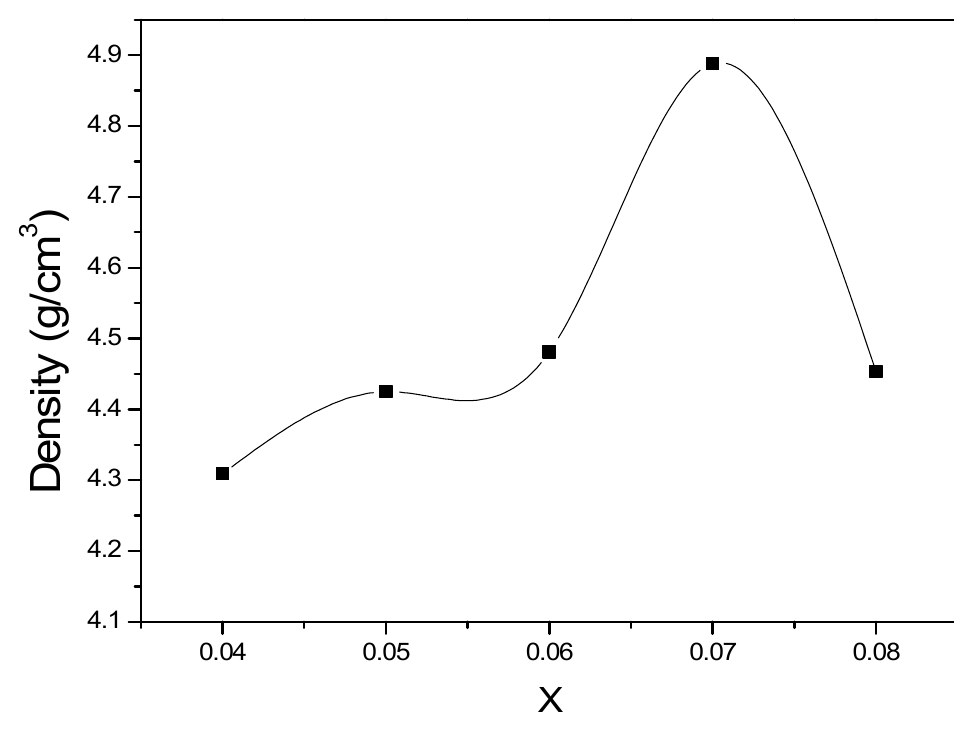
Figure 4. Density of samples with the amount of antimony.